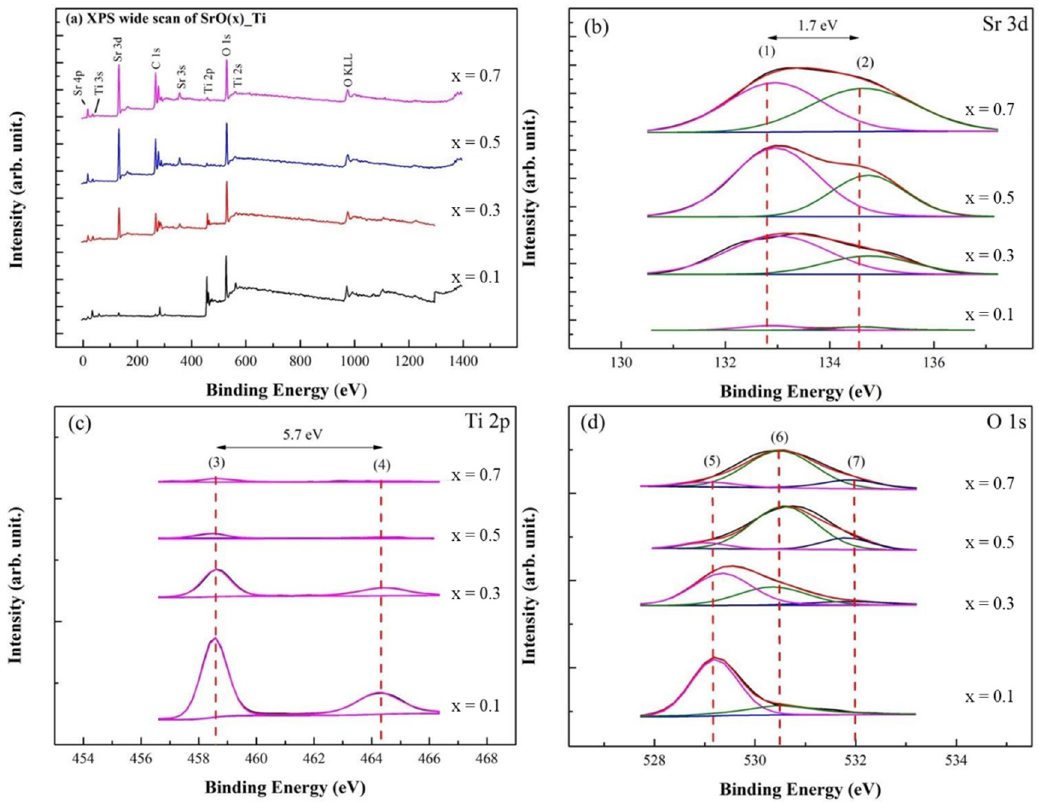
Figure 2. XPS studies of SrO_TiO 2 _P (x) (x = 0.1, 0.3. 0.5, or 0.7) before transesterification process were demonstrated: ( a ) Wide-scan XPS spectra and ( b ) curve-fitted XPS spectra for Sr 3d, ( c ) Ti 2p, and ( d ) O 1s. The curve-fitted peaks are respectively assigned at: (1) 132.9 eV, Sr 3d5/2, (2) 134.6 eV, Sr 3d3/2, (3) 458.6 eV, Ti 2p3/2, (4) 464.3 eV, Ti 2p1/2, (5) 529.2 eV, Sr-Ti, (6) 530.5 eV, Sr-O, and (7) 532.0 eV, loosely bound hydroxide groups.